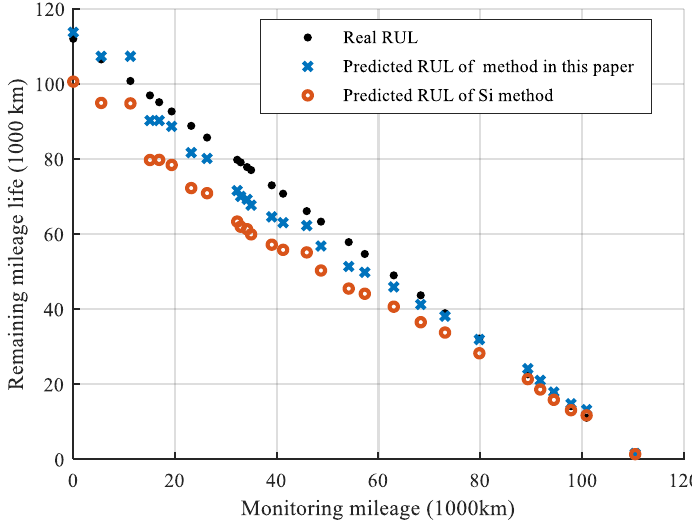
Figure 21. Prediction results of the RUL in the two methods.